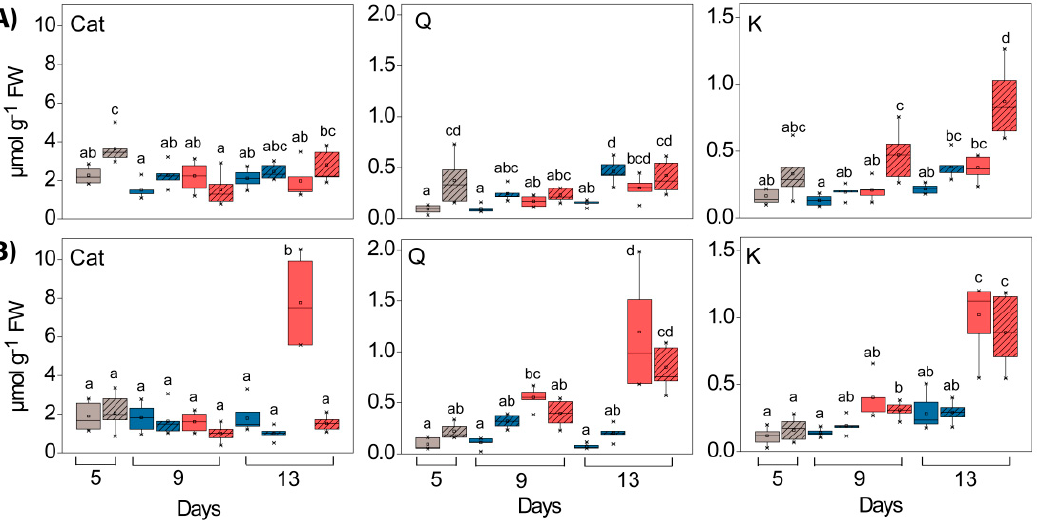
Figure 6. Changes in the composition of flavan-3-ols (catechin, Cat) and flavon-3-ols (quercetin, Q and kaempferol, K) in GL (solid boxes) and WL (striped boxes) of P. zonale plants before (5 d, grey) and after four (9 d) and eight days (13 d) of high light exposure (HL, 800 µmol m –2 s –1 , red bars) compared to plants exposed to low light (LL, 180 µmol m –2 s –1 , blue bars) at ( A ) optimal temperature of 25 °C ( HL ) and ( B ) lower temperature of 18 °C ( Cold + HL ). Values are shown in µmol g –1 FW ± SE, n = 5–9. Different letters indicate statistically significant differences between different PAR intensities, time points, and leaf tissues ( p < 0.05) according to Tukey’s post hoc test.